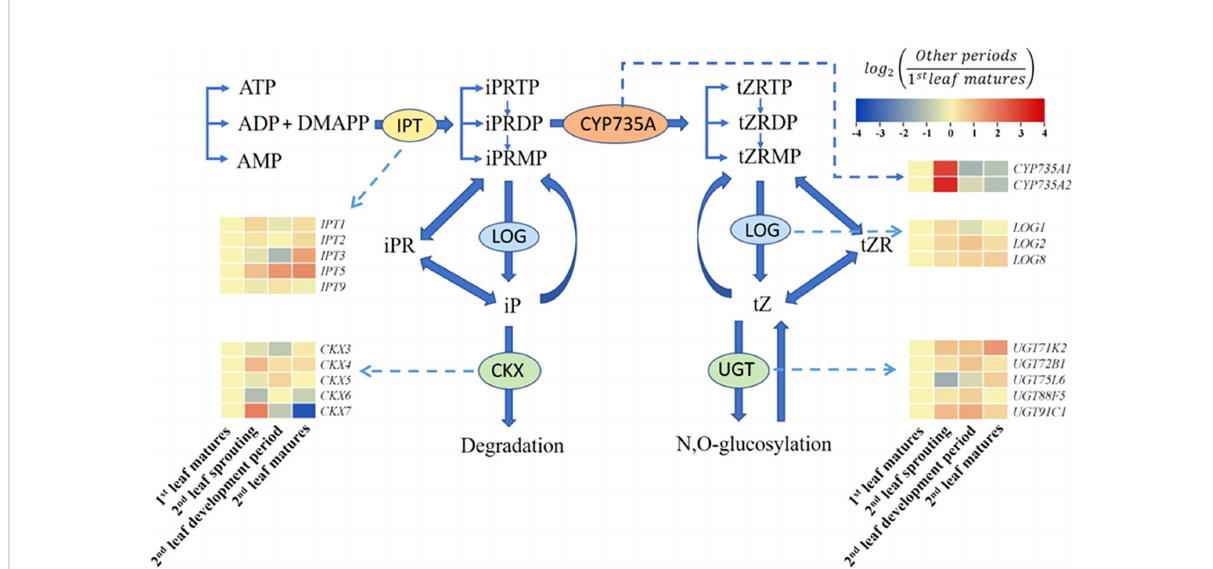
FIGURE 4 Summary of the cytokinin biosynthesis and catabolism pathways (modi fi ed from Osugi and Sakakibara, 2015). Changes in transcript levels are indicated by color codes. Red shows upregulated, and blue indicates downregulated of gene expression (using FPKM values) compared with fi rst leaf matures period. Two color log scales are